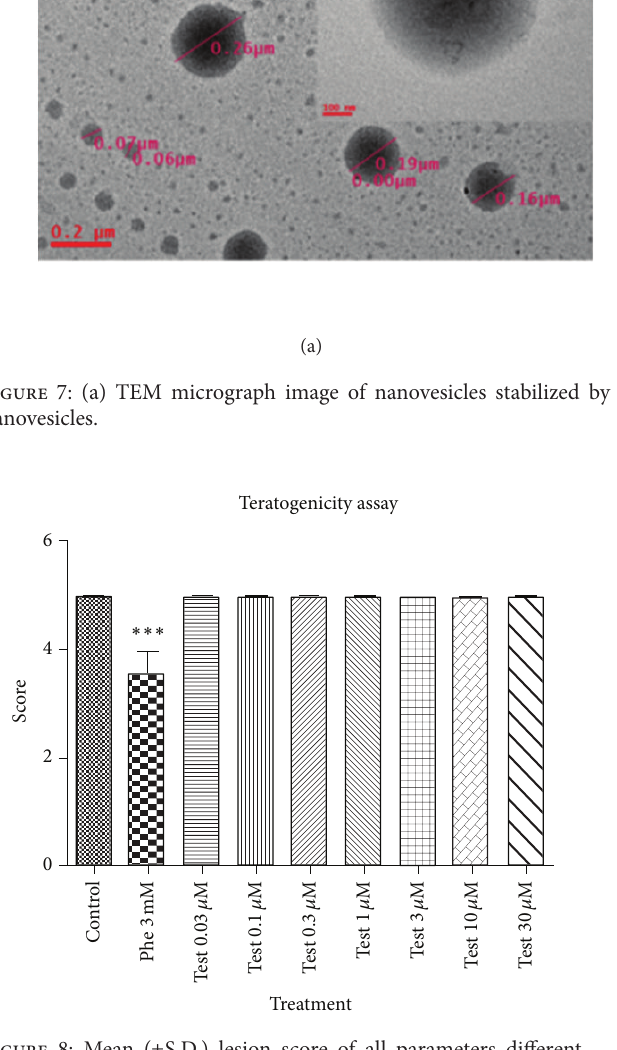
Figure 8: Mean ( ± S.D.) lesion score of all parameters different treatment groups. ( ∗ 𝑃 < 0.05 , ∗∗ 𝑃 < 0.01 and ∗∗∗ 𝑃 < 0.001 .) Statistical significance was analyzed as control group versus all